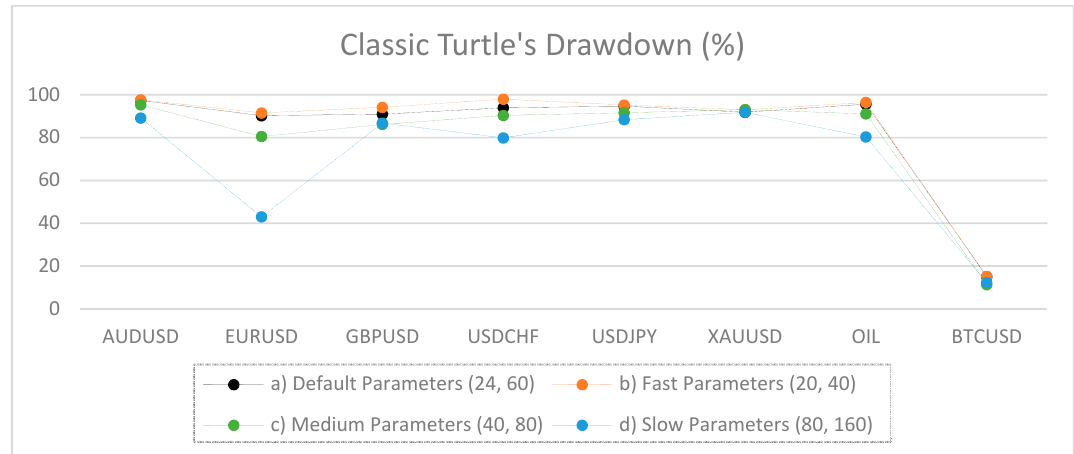
Figure 7. Net profits for experiments (a), (b), (c) and (d).